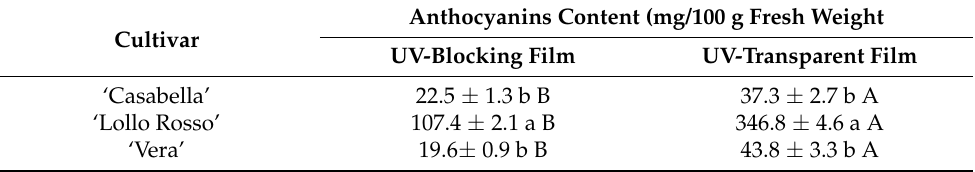
Table 2. The effect of plastic film on the anthocyanin content in three cultivars of lettuce at harvest (eight weeks after showing). Expressed in mg/100g fresh weight. Cultivar